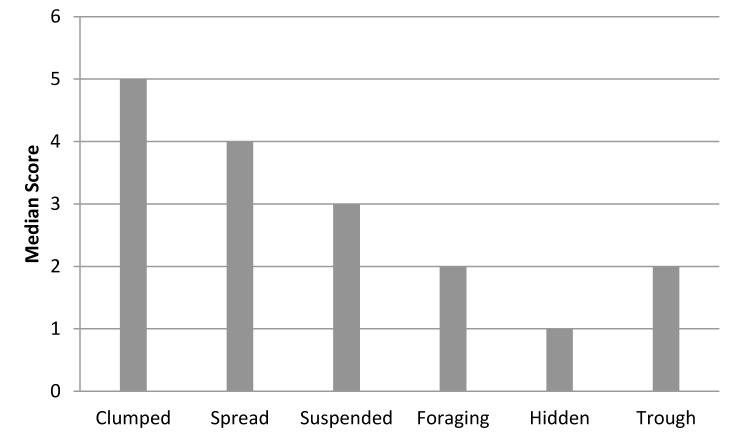
Median scores for feed presentation methods from zoos that used each method.Each categorical scale score represents use ranges in 10% increments (e.g., 1 = 1–9%, 2 = 10–19%). Scores of 0 represent no use and scores of 11 represent use 100% of the time. Categories included clumped [food placed in piles composed of multiple flakes of hay, browse items, or pellet] (66 zoos used this method), spread [food distributed through the exhibit] (66 zoos used this method), suspended [food suspended by rope, in a bag, open sided barrel, etc.] (63 zoos used this method), foraging [food provisioned in a feeding apparatus], hidden [food hidden around the exhibit] (59 zoos used this method), trough [food placed in an open trough] (29 zoos used this method).